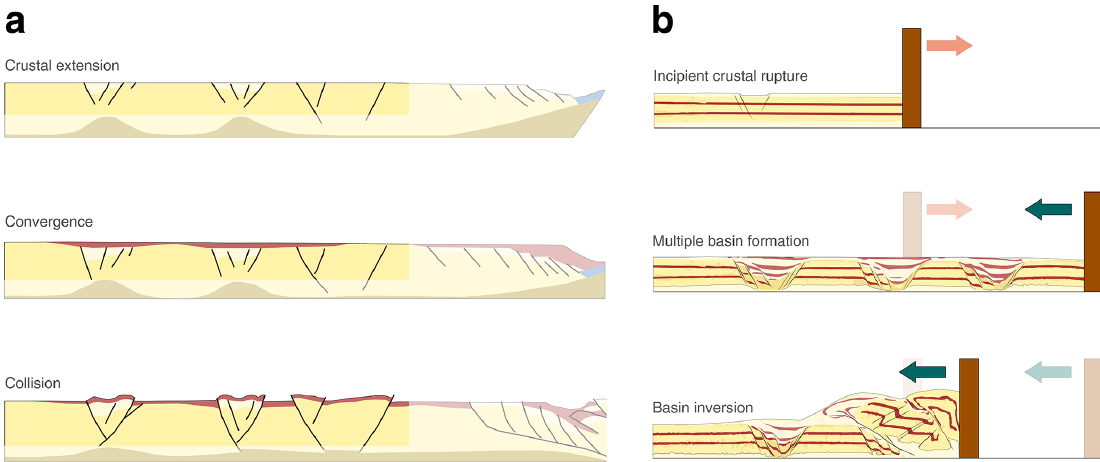
Figure 1. (a) Conceptual model of crustal extension and later foreland compressional deformation (redrawn from Ziegler, 1989). (b) Sketch representing the equivalent modelling stages presented in this